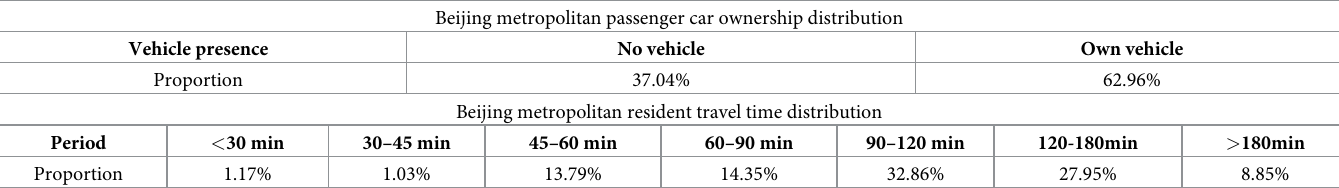
Table 4. Population vehicle ownership distribution and travel time distribution in beijing metropolitan area.